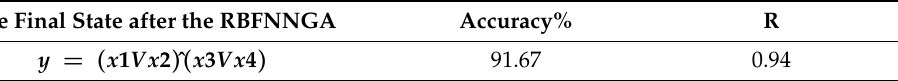
Figure 4. Predicting L-asparaginase data using a hybrid RBFNNGA model. RMSE valuation ( A ); MAPE valuation ( B ); SEP assessment ( C ); MAE evaluation ( D ); AIC assessment ( E ). Table 5. Shows the best accuracy, correlation coefficient (R), and the most influencing variables. Best accuracy and correlation coefficient